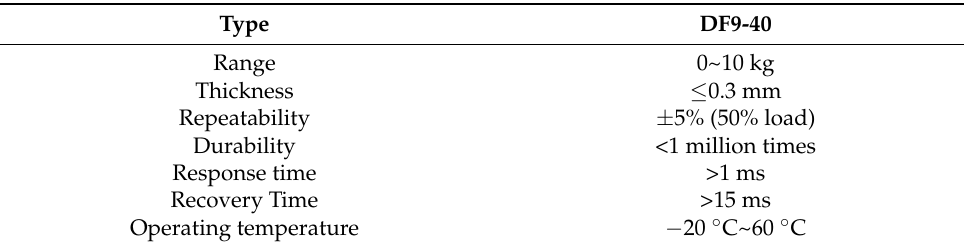
Figure 13. Thin-film pressure sensors and transmitters. Table 2. Resistive film pressure sensor parameter table.